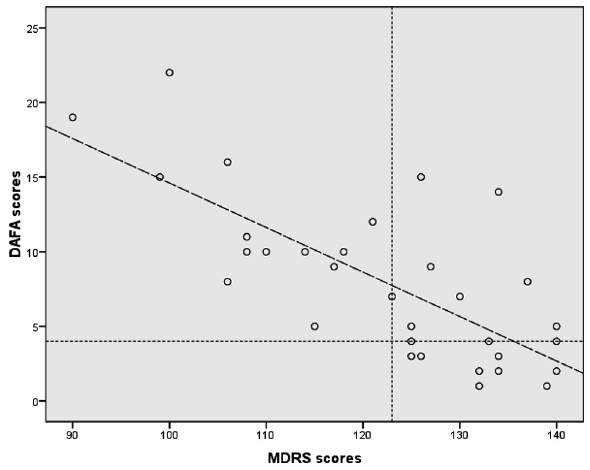
Figure 1. Scatter plot of patient scores on the Direct Assessment of Functional Ability (DAFA) and on the Mattis Dementia Rating Scale (MDRS). The dashed horizontal line represents the best DAFA cut-off score to predict an abnormal score on the MDRS. The dashed vertical line represents the best general MDRS cut-off score to predict dementia. The dashed sloped line represents the estimated regression line (linear regression equation – y = 44.4 – 0.298x).